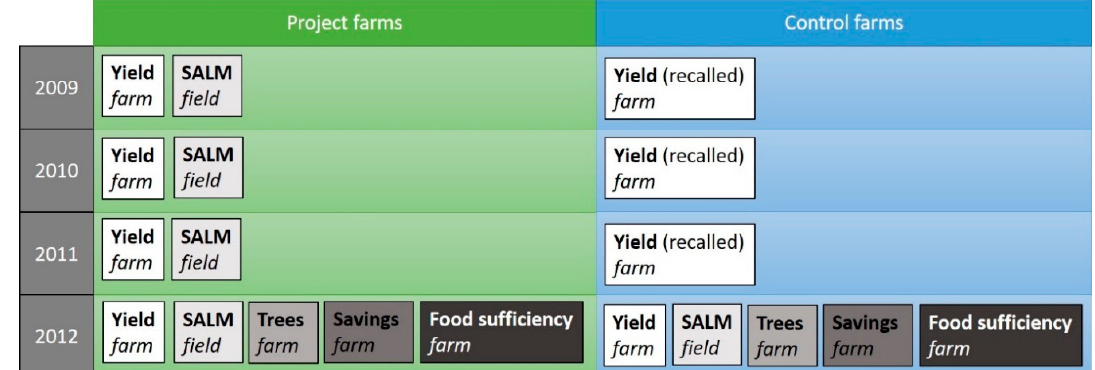
Figure 2. Available data for project and control farms over the years analysed and the scale of the analysis. All data were compared between project and control farms when possible, except for the effects of SALM and trees on maize yield.